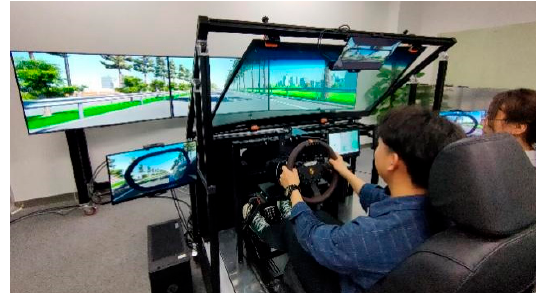
Figure 6. Driving simulator used in the study.